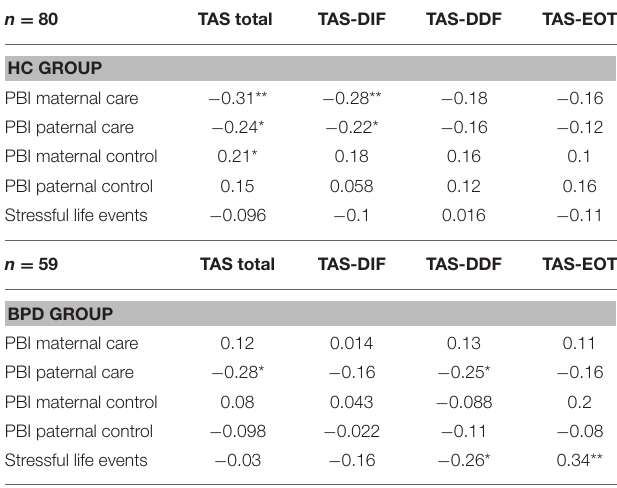
TABLE 3 | Correlations between adversity and alexithymia in BPD and HC groups.